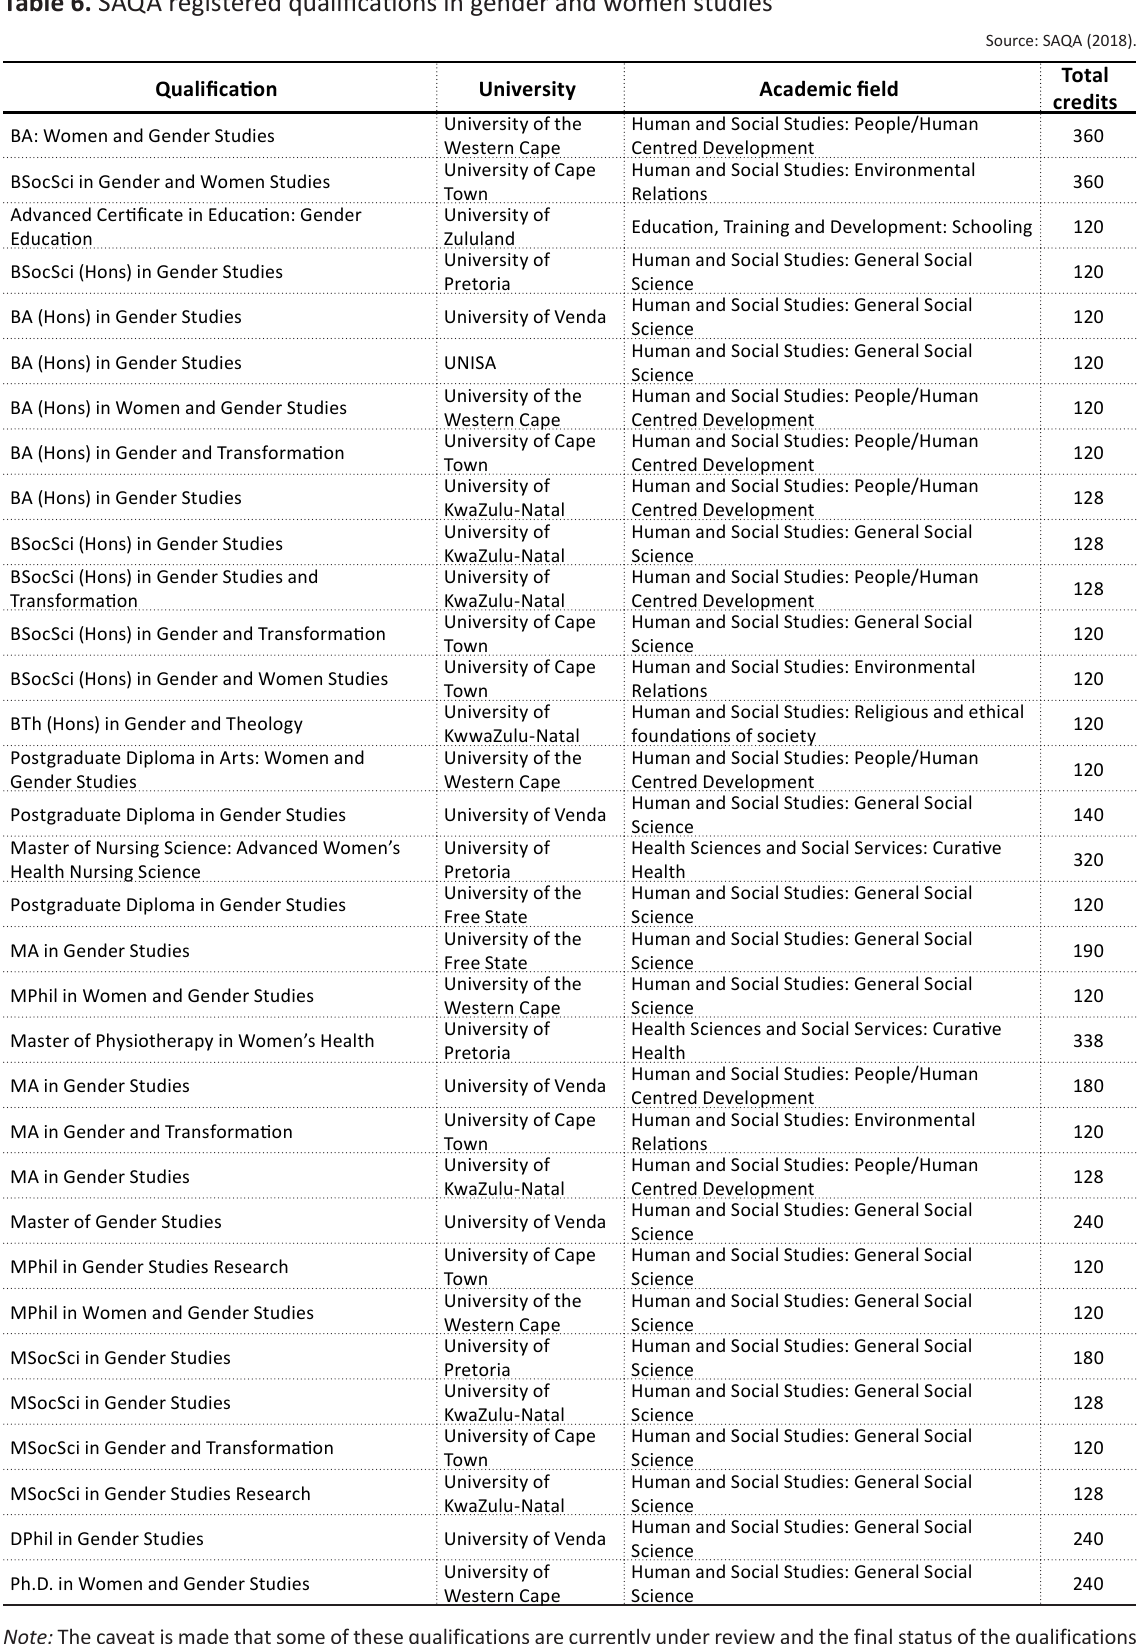
Table 6. SAQA registered qualifications in gender and women studies